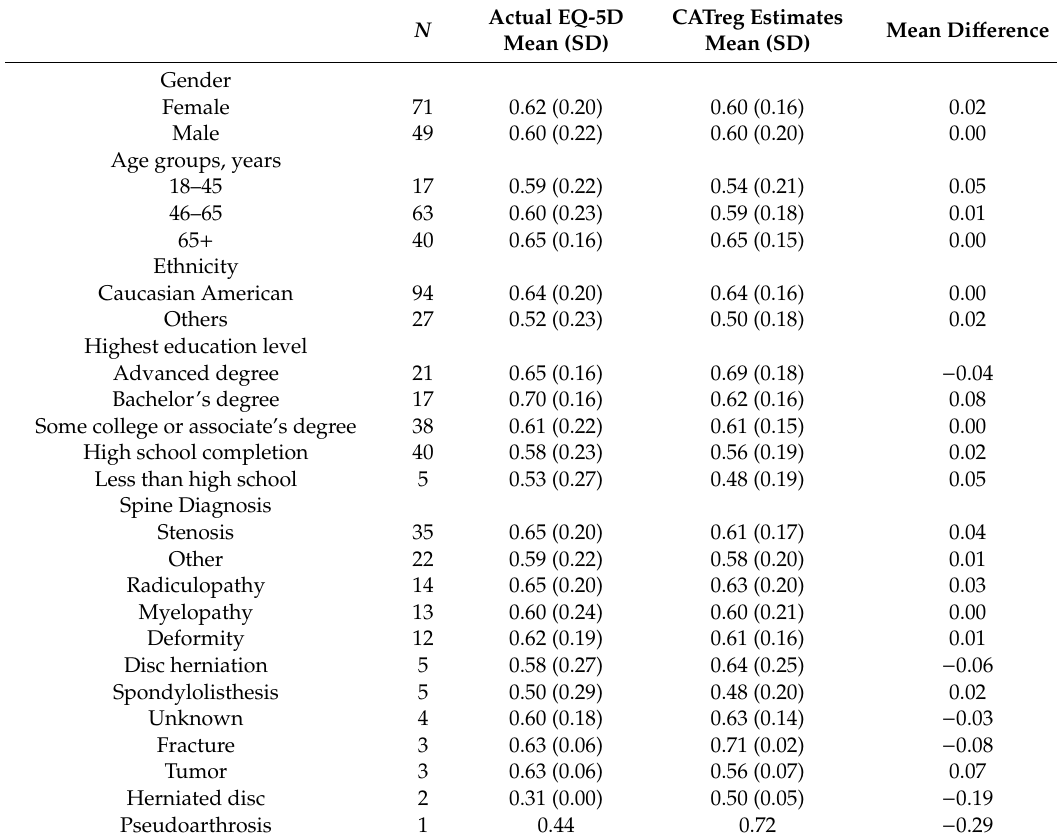
Table 3. Comparison of actual EQ-5D scores and estimates of the CAT reg model by